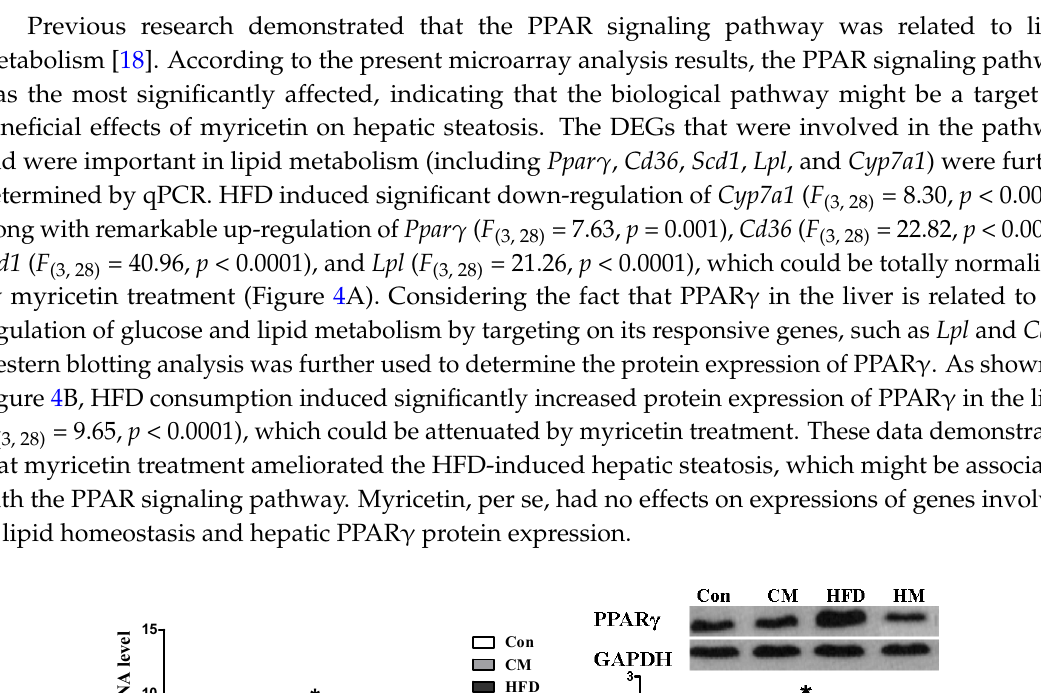
Table 2. Significantly altered biological pathways in livers of the HM mice compared to HFD mice.